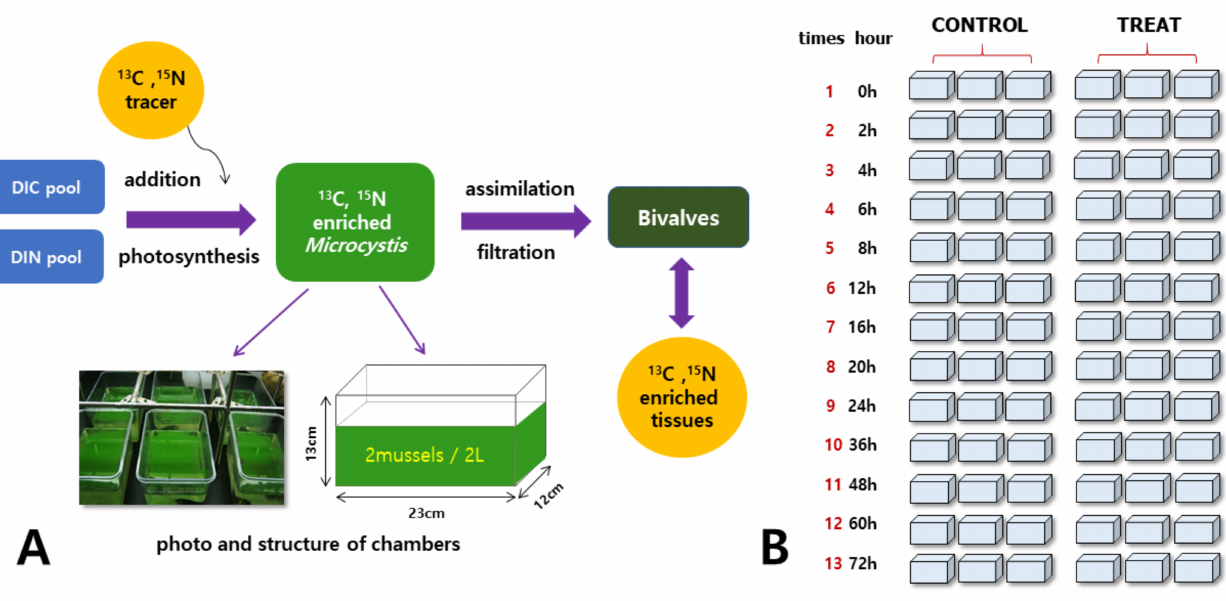
Figure 1. Feeding and assimilation experiments of freshwater bivalve Unio douglasiae Griffith et Pidgeon in Microcystis - predominating waters for 72 h. ( A ) Enrichment of carbon and nitrogen tracer by mussel feeding: ( B ) 78 trial chambers labeled CONTROL (3 replicates × 13 times) and TREAT (3 replicates × 13 times) were used in this study. Animal density in each TREAT chamber is indiv. L − 1